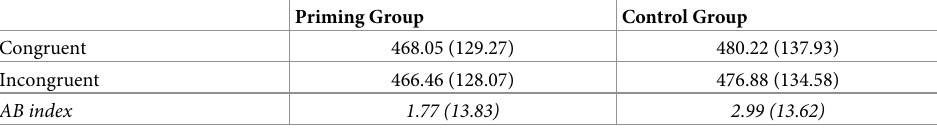
Table 2. Mean ( SD ) for the reaction time data (ms) of the subliminal dot-probe task for itch per group (priming vs. control) and congruency (congruent vs. incongruent) ( n =